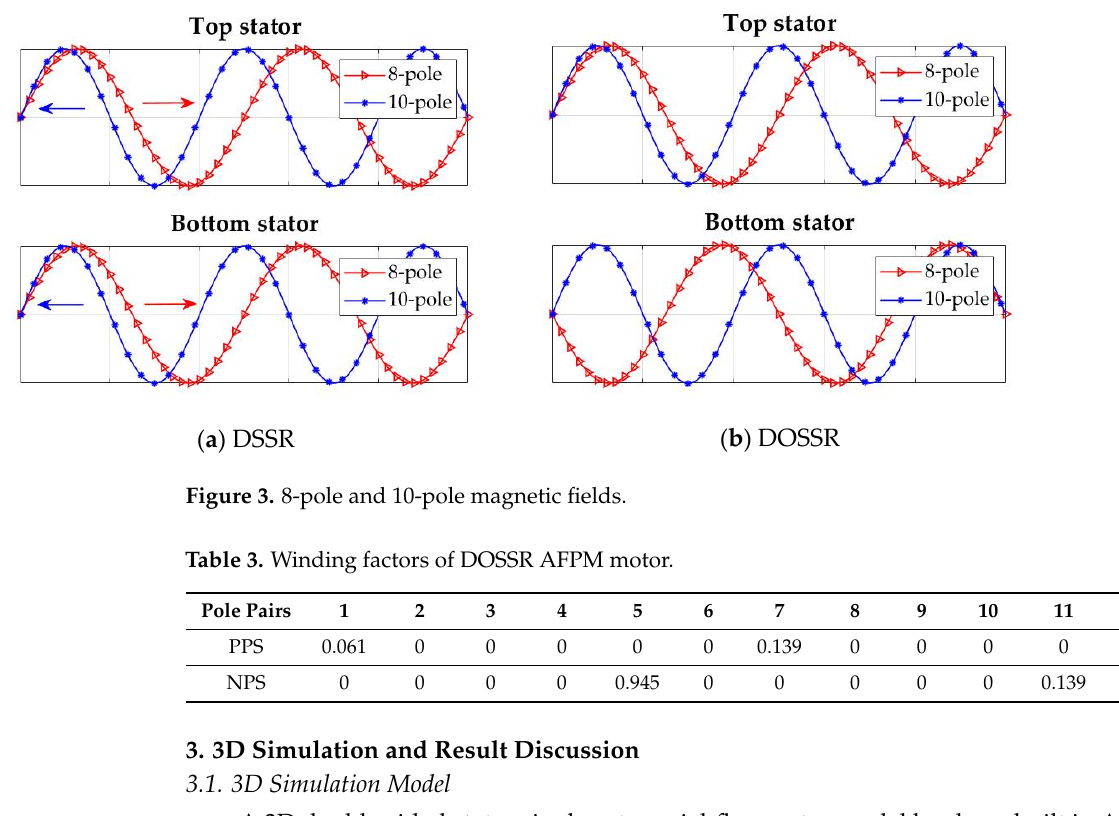
Table 2. Winding factors of the DSSR motor.